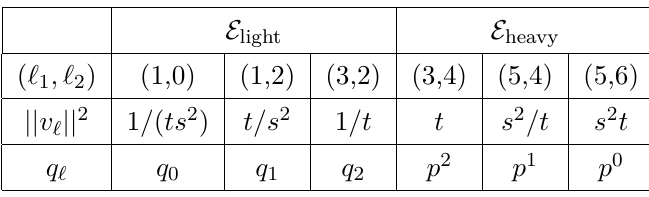
Table 3. Limit III 0 → IV 2